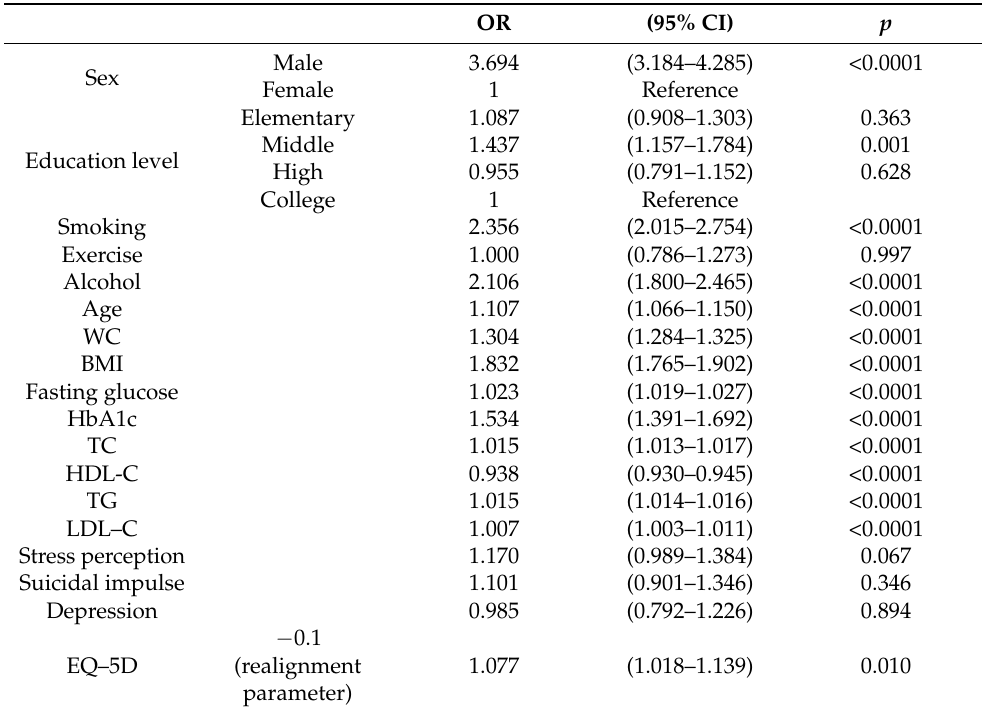
Table 2. General characteristics and the association between MAFLD and stress, mental health, and HRQoL.